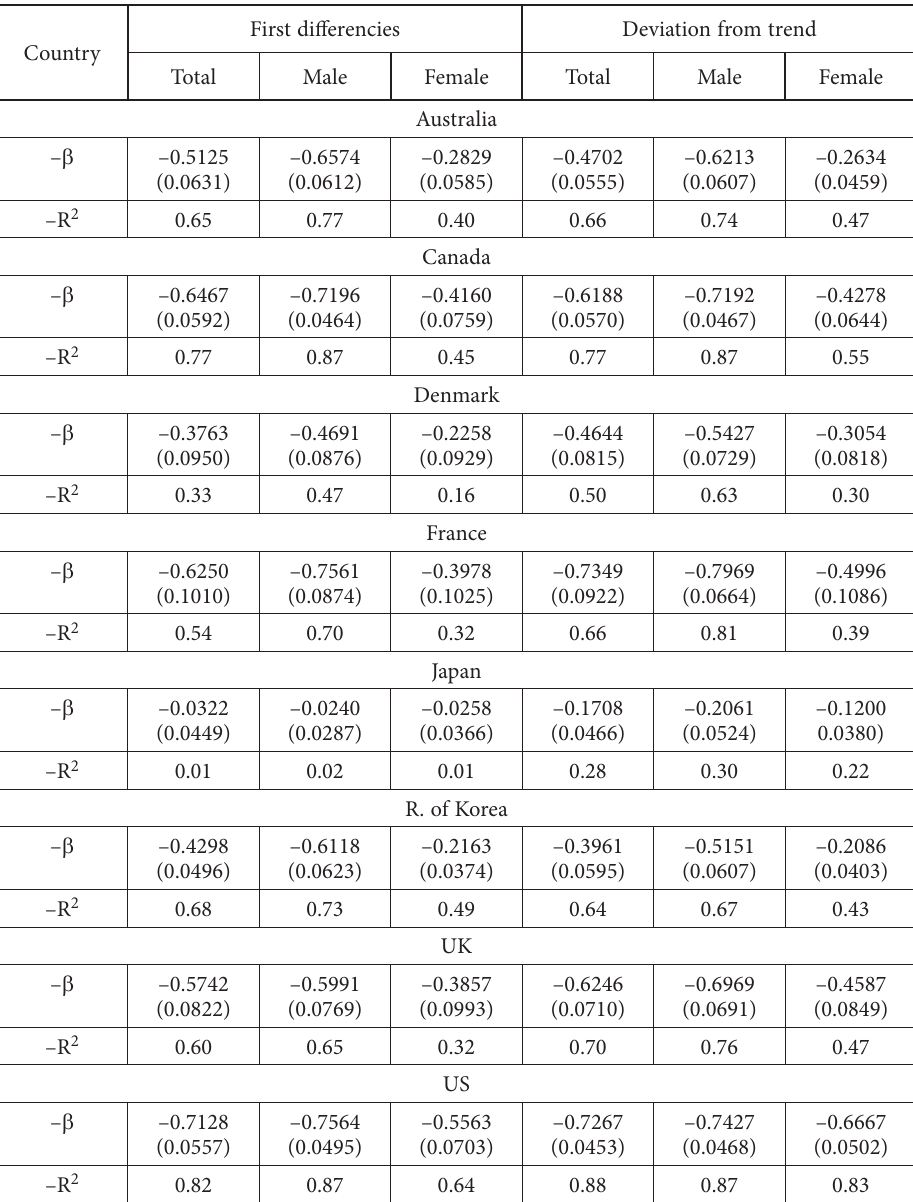
Table 2. Changes in a number of unemployed and changes in a number of working persons – results of the regression analysis (model estimated based on the first differences in variables and model estimated based on deviations of variables from the trend) in selected countries in the years 1981–2018 (source: own calculations based on the ILO